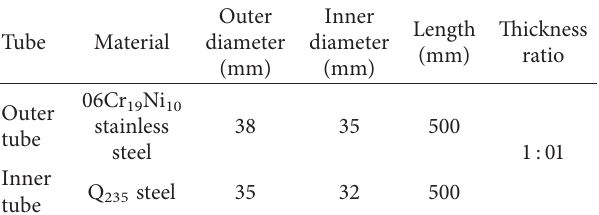
Table 3: The parameters of the clad tube billet.